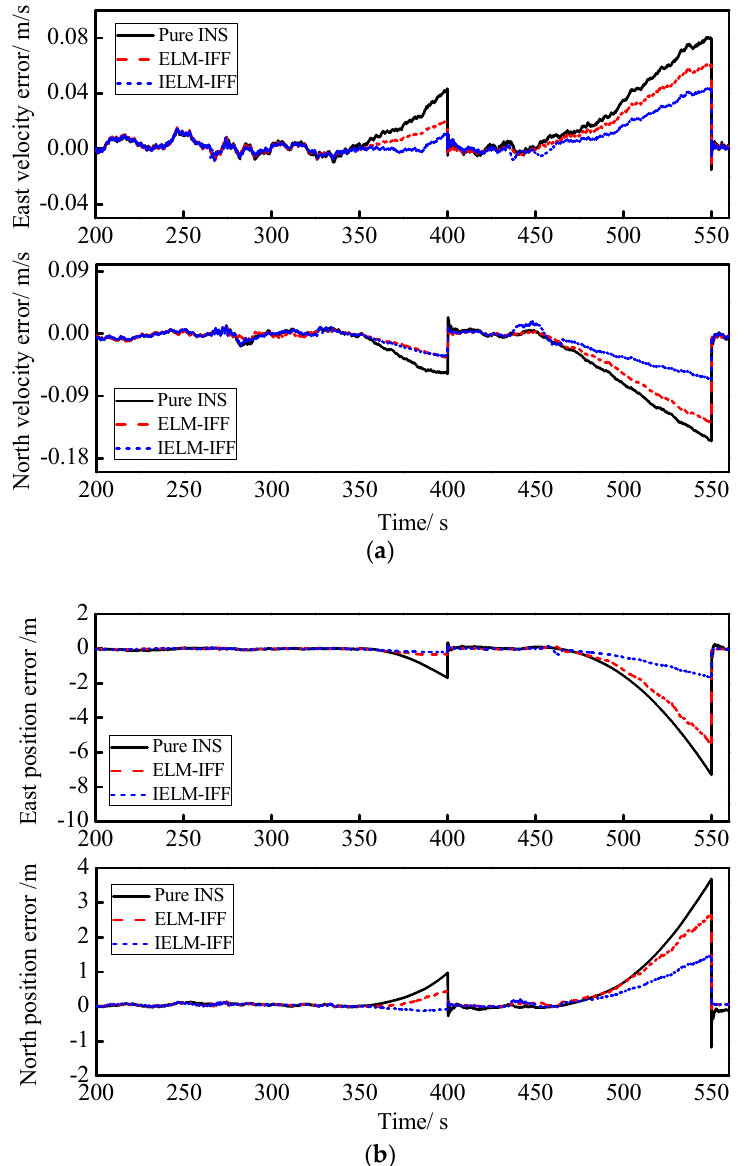
Figure 8. Curves of velocity and position errors: ( a ) east and north velocity errors for pure INS, ELM-IFF, and IELM-IFF; ( b ) east and north position errors for pure INS, ELM-IFF, and IELM-IFF. ELM: extreme learning machine.